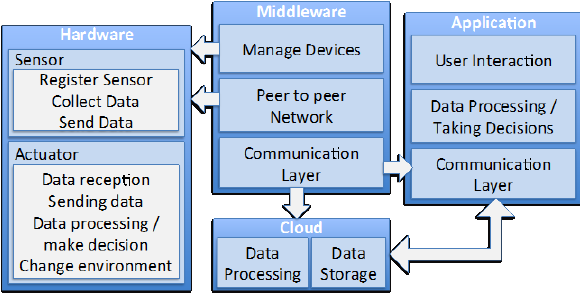
Figure 2. Detailed